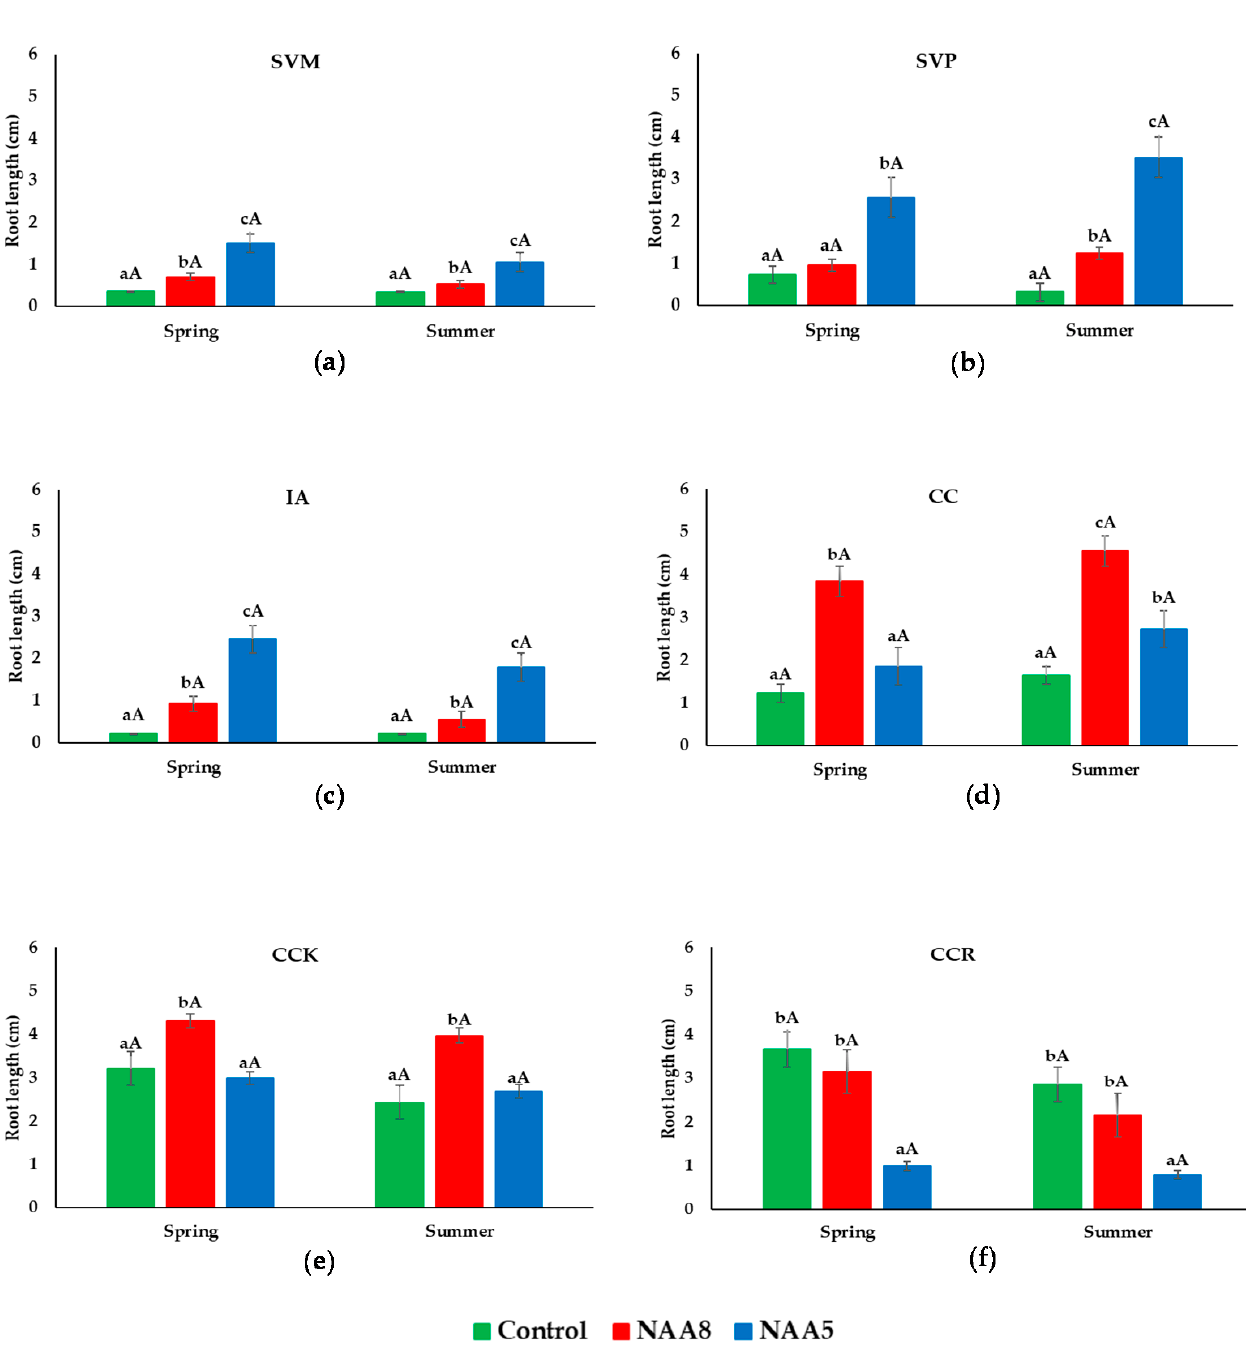
Figure 4. Effect of rooting stimulants (NAA8 and NAA5) on root length in the six selected ornamental shrubs: ( a ) Syringa vulgaris ‘Mme Lemoine’ (SVM); ( b ) Syringa vulgaris ‘President Grevy’ (SVP); ( c ) Ilex aquifolium (IA); ( d ) Cotinus coggygria (CC); ( e ) Cotinus coggygria ‘Kanari’ (CCK); ( f ) Cotinus coggygria ‘Royal Purple’ (CCR). Bars represent the means ± SE ( n = 30). Different lowercase letters above the bars indicate significant differences between the treatments, and different uppercase letters indicate the significant differences between the spring and summer propagated cuttings, according to Tukey’s test ( α =